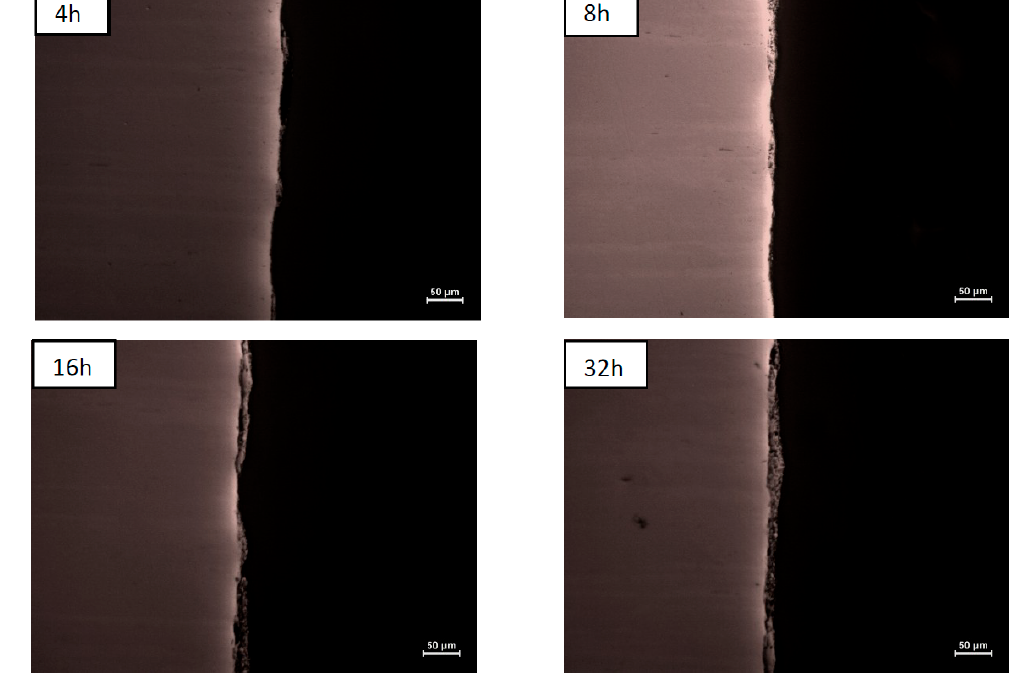
Figure 4. Images of composite coatings on steel substrates milled for 4, 8, 16, and 32 h. Table 1. Average thickness of coatings on nickel and steel substrates obtained after various milling times.